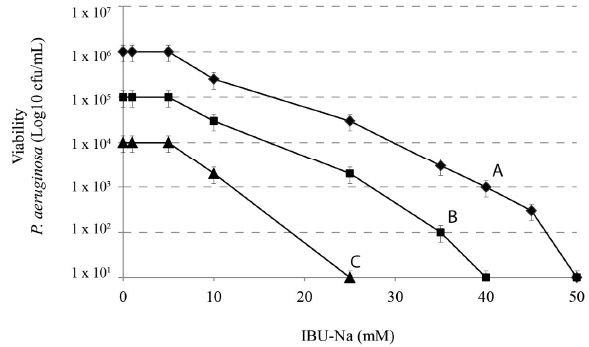
Figure 3. IBU-Na activity as a function of different initial inoculum titres. Effects of IBU-Na (1, 5, 10, 25 and 50 mM) were tested at three different initial inoculum densities referred to as Population A (cid:7) - (cid:7) (1 × 10 6 cfu/mL), B (cid:4) - (cid:4) (1 × 10 5 cfu/mL) and C - (1 × 10 4 cfu/mL), obtained from decimal serial dilutions of P. aeruginosa 1 × 10 7 cfu/mL. The incubation was performed for 4 h at 37 ◦